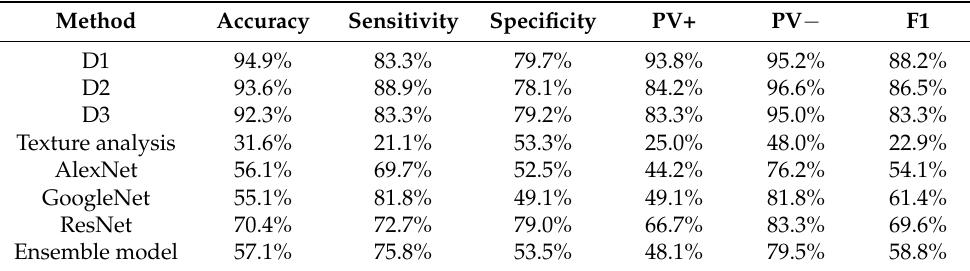
Table 3. Performances of dermatologists and automated methods on test set